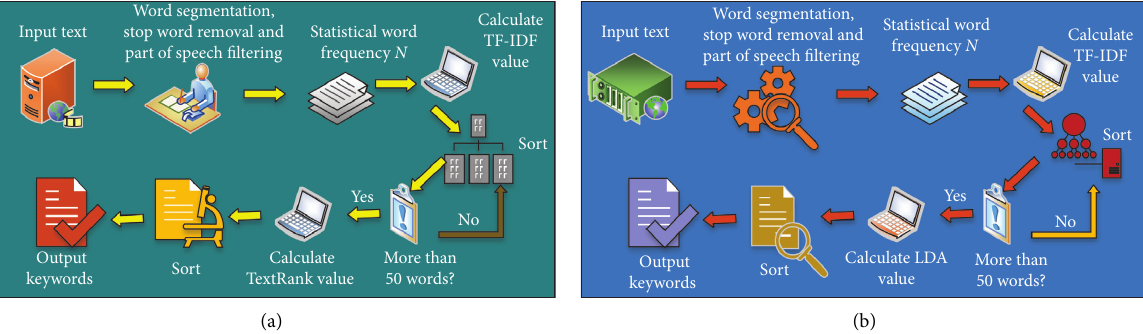
Figure 6: Two methods of keyword extraction for online news based on waterfall fusion. (a) Scheme 1 flow chart. (b) Scheme 2 flow chart.